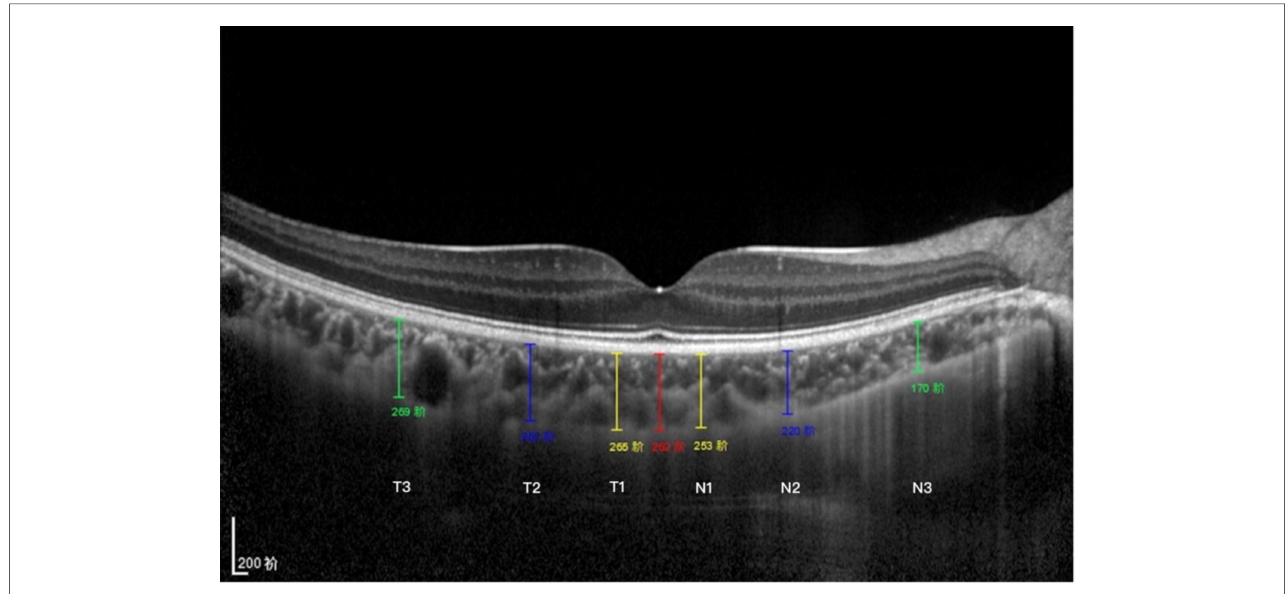
FIGURE 1 Subfoveal CT measurement. CT was measured at 7 points: directly beneath the fovea or the subfoveal area (SFCT) point, and 0.5/1.5/3 mm to the fovea nasally (N1/N2/N3), 0.5/1.5/3 mm to the fovea temporally